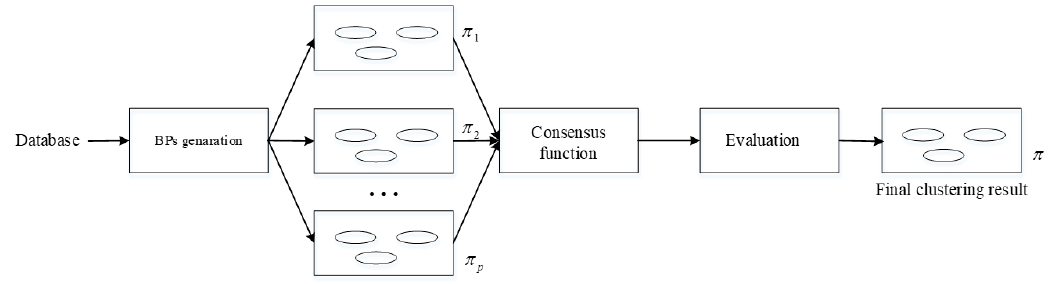
Figure 1. Consensus clustering framework